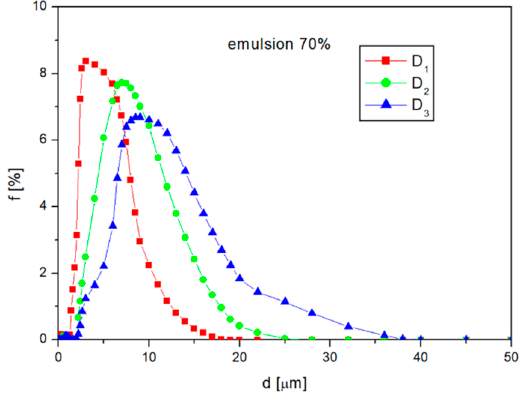
Figure A2. Oil droplet diameter distributions of 70% emulsion at different mixing times.